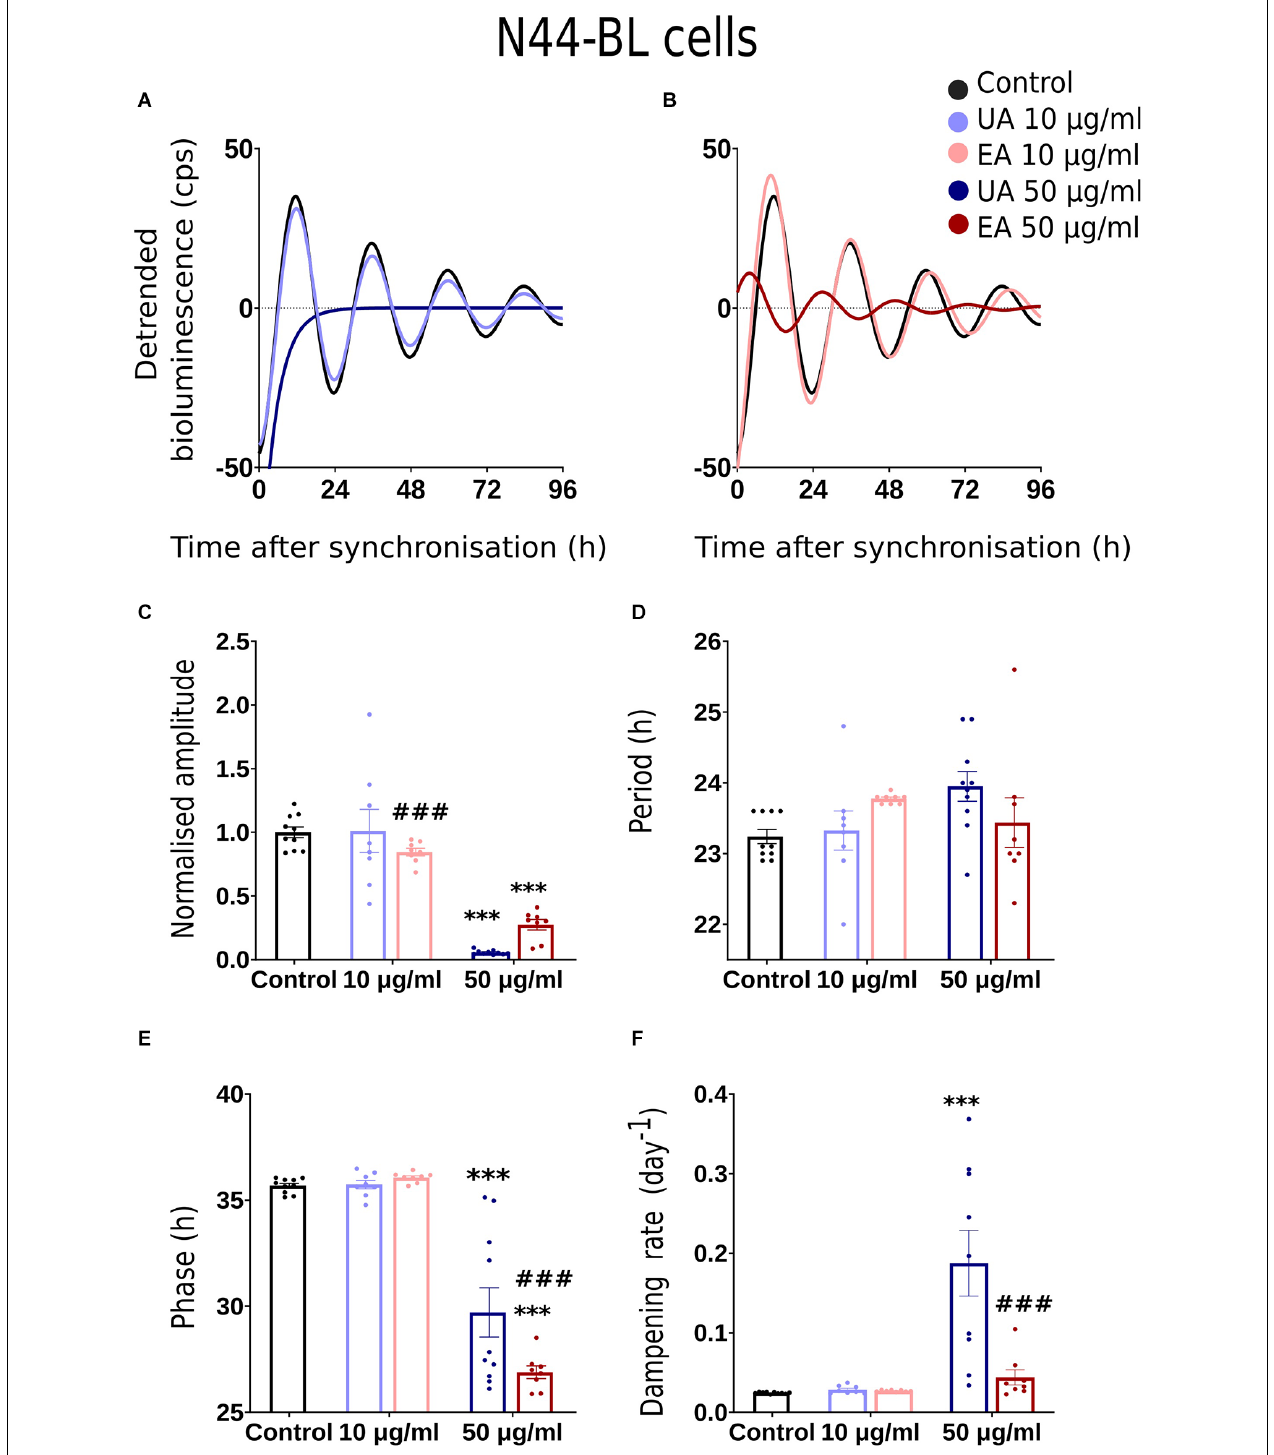
FIGURE 2 | Effects of lichenized secondary metabolites on circadian luminescence rhythms of N44-BL cells. Representative curve fits of Bmal1:luc luminescence rhythms in N44 cells after treatment with different doses of usnic acid ( A , UA/Blue) or evernic acid ( B , EA/Red). Amplitude (C) , Period (D) , Phase (E) , and Dampening effects (F) on bioluminescence rhythms in N44 cells after treatment with EA (10 or 50 µ g/ml; red) or UA (10 or 50 µ g/ml; blue) vs. solvent control (PBS/ DMSO; black). Single measures are shown; error bars indicate means ± SEM ( ∗∗∗ p < 0.001; 2-way ANOVA with Tukey’s post-test). ### p < 0.001 between UA 10 vs. EA 10 or UA 50 vs. EA